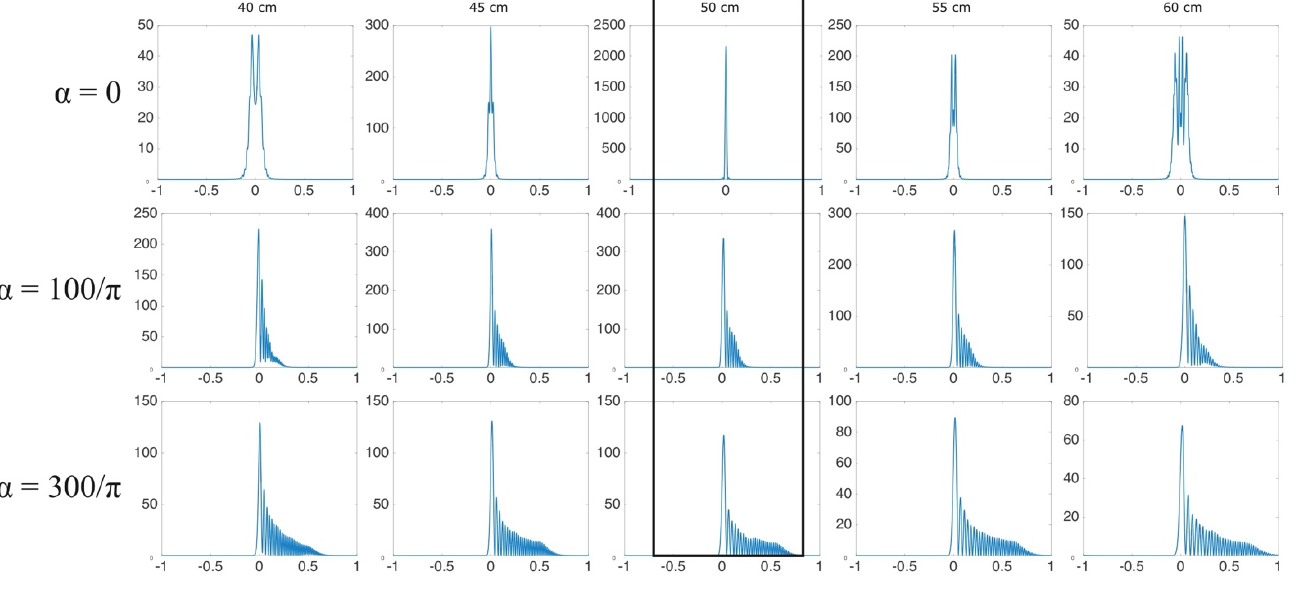
Figure 4. Horizontal PSF profiles of the combined APM + FL imaging system with α = { 0, 100/ π , 300/ π } in different z (cid:48) -image positions (the central rectangle highlights those in the in-focus position). Results obtained by numerical simulation.